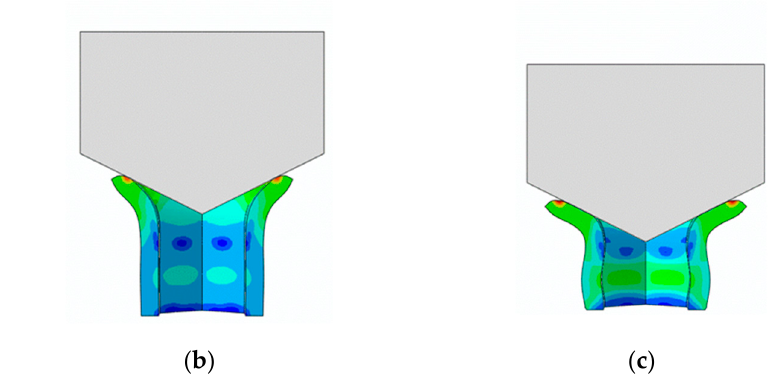
Figure 22. Behaviour of SHORT structure under compressive loading in time depicted using FEM simulation ( a ) the first contact between punch and sample, ( b ) sample expansion, ( c ) sample barreling.